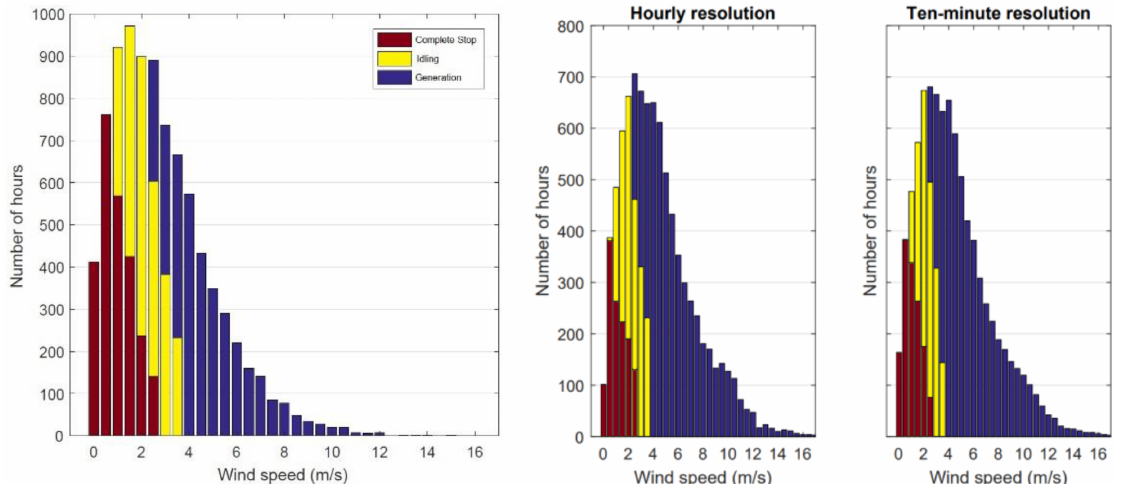
Figure 23. ( left graph) Case study for different wind turbine states in legend: (State Zero) rotor at complete stop and turbine not generating, (State One) rotor is idling and not generating, and (State Two) rotor is rotating and generating. ( middle and right graph) Different time